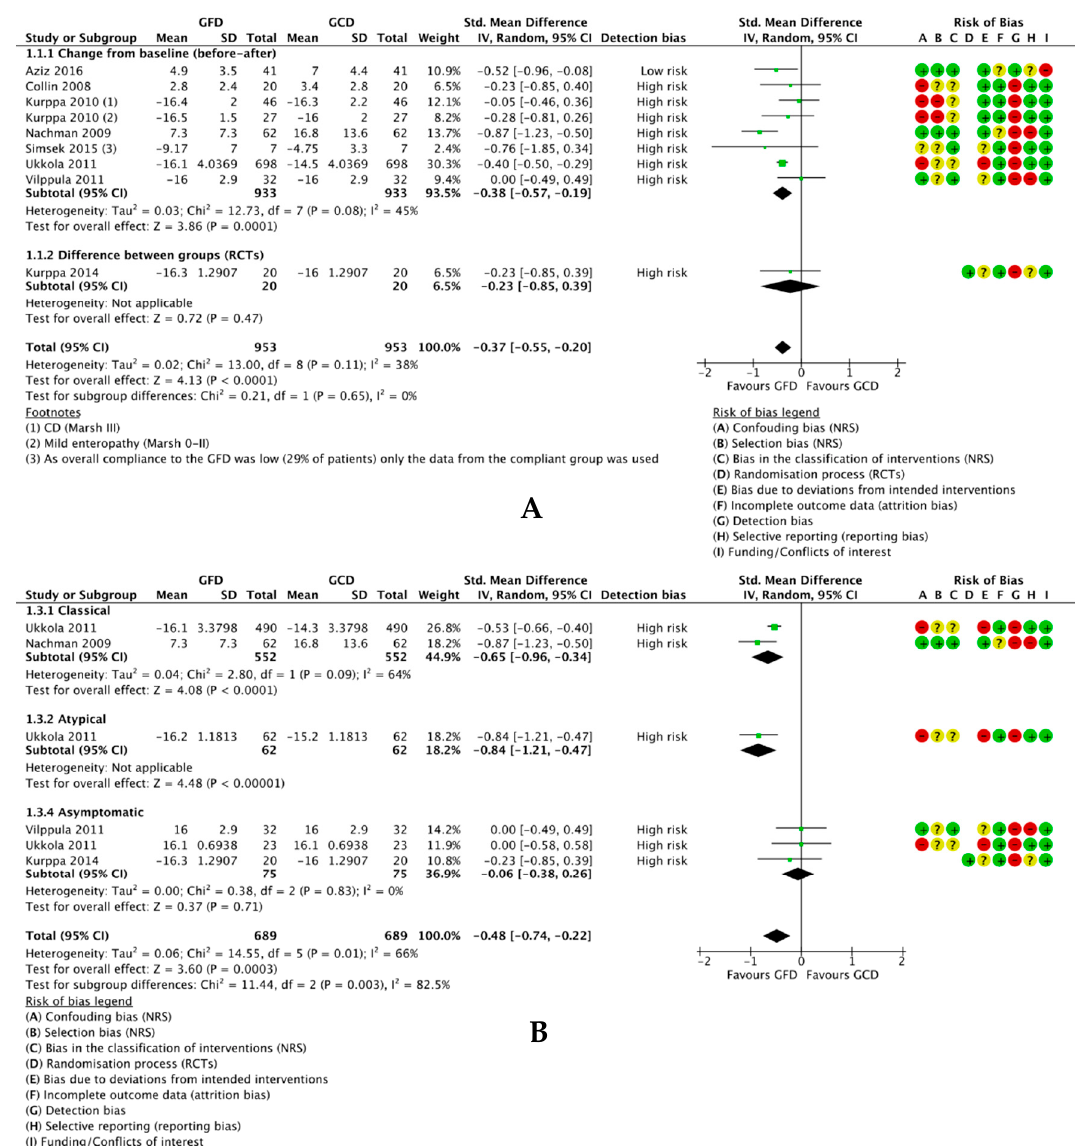
Figure 3. Forest plot demonstrating the difference in mean depression scores between following a GFD and a gluten-containing diet for ( A ) all studies (1 RCT comparing two intervention groups and seven BA studies comparing participant scores at baseline) and ( B ) subgroup analysis based on symptoms (classical, atypical and asymptomatic). CI, confidence interval; df, degrees of freedom; GFD, gluten-free diet; GCD, gluten-containing diet; I 2 , heterogeneity; IV, inversed variance; Random, random effects model; SD, standard deviation; Std., standardised; total, number of